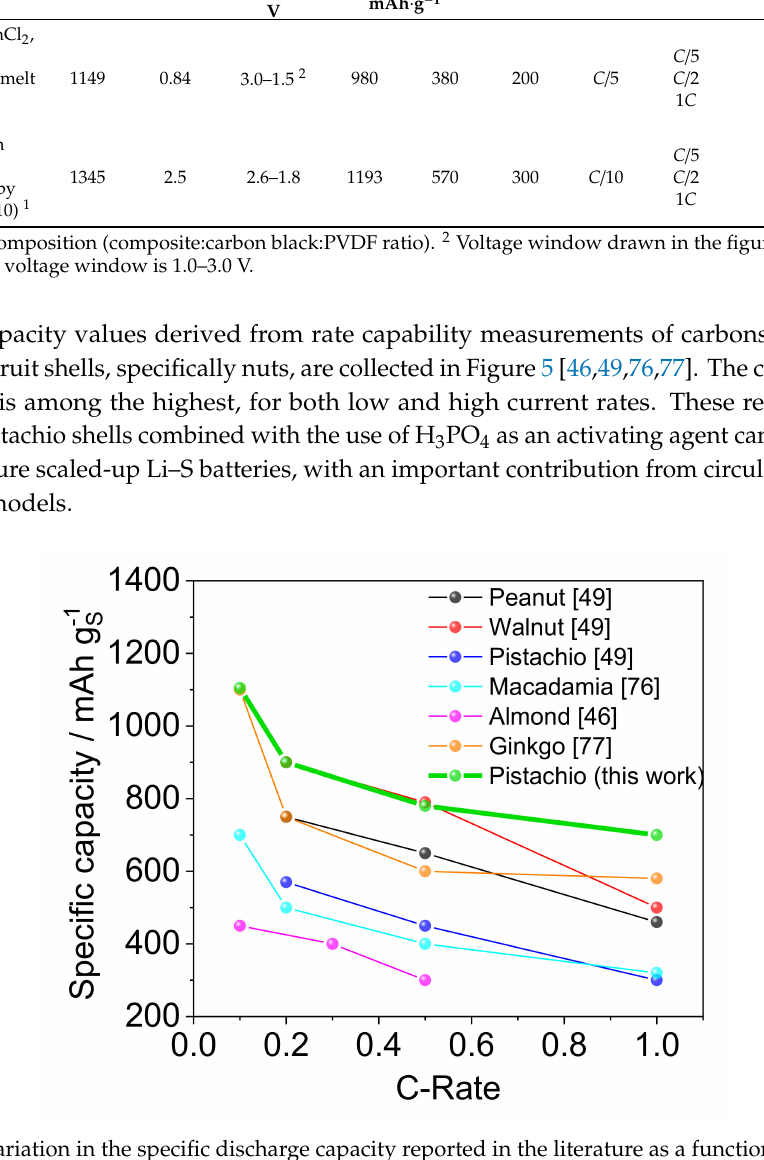
Table 1. Selected properties of lithium–sulfur (Li–S) cells made from activated carbons derived from pistachio shells (reported in the literature). The properties of our carbon are also included for comparison.